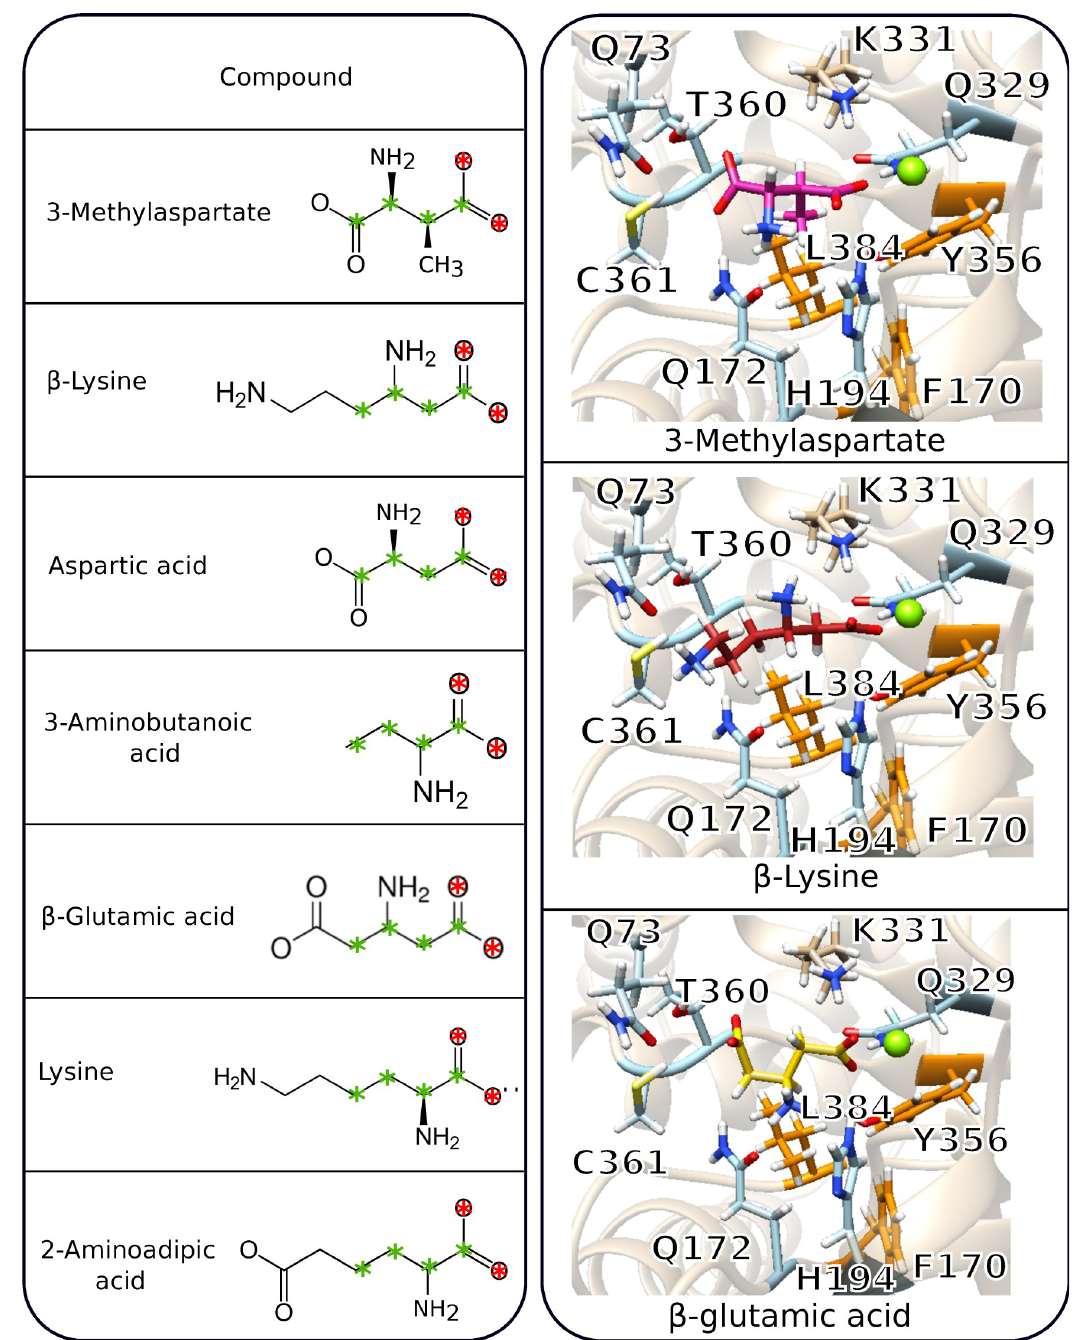
Fig 5. Results of docking analysis. The structures of the natural substrate (3-methylaspartate) and the investigated substrates are shown in the left panel, together with the description of their structural differences compared with the natural substrate. The carbon atoms, indicated in green, and the oxygen atoms, in red, constitute a common scaffold in all the substrates, and these atoms were used for the RMSD calculations. The right panel shows the catalytic pocket of CaMAL (shown as the pale brown cartoon) with the natural substrate (upper panel, PDB entry 1KKR, shown in magenta), one example of the complexes with lysine (middle panel, shown in light pink) and β -lysine (lower panel, shown in red) obtained by docking calculations. difference in the orientation of the ligands with respect to the hydrophobic residues in the catalytic pocket of CaMAL (residues L384, F170, Y356 shown as orange sticks) and the residue Q172 (shown as blue sticks), which takes part in the hydrogen bond network. The interactions predicted for the other ligands in the catalytic pocket of CaMAL are shown in S7